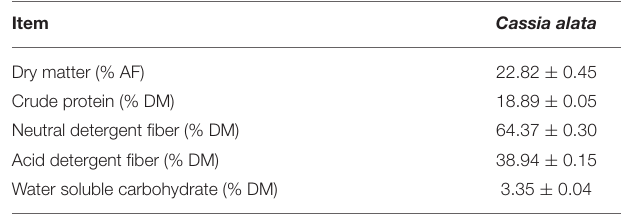
TABLE 1 | Nutrients of fresh Cassia alata prior to ensiling ( ± SD, n = 3).